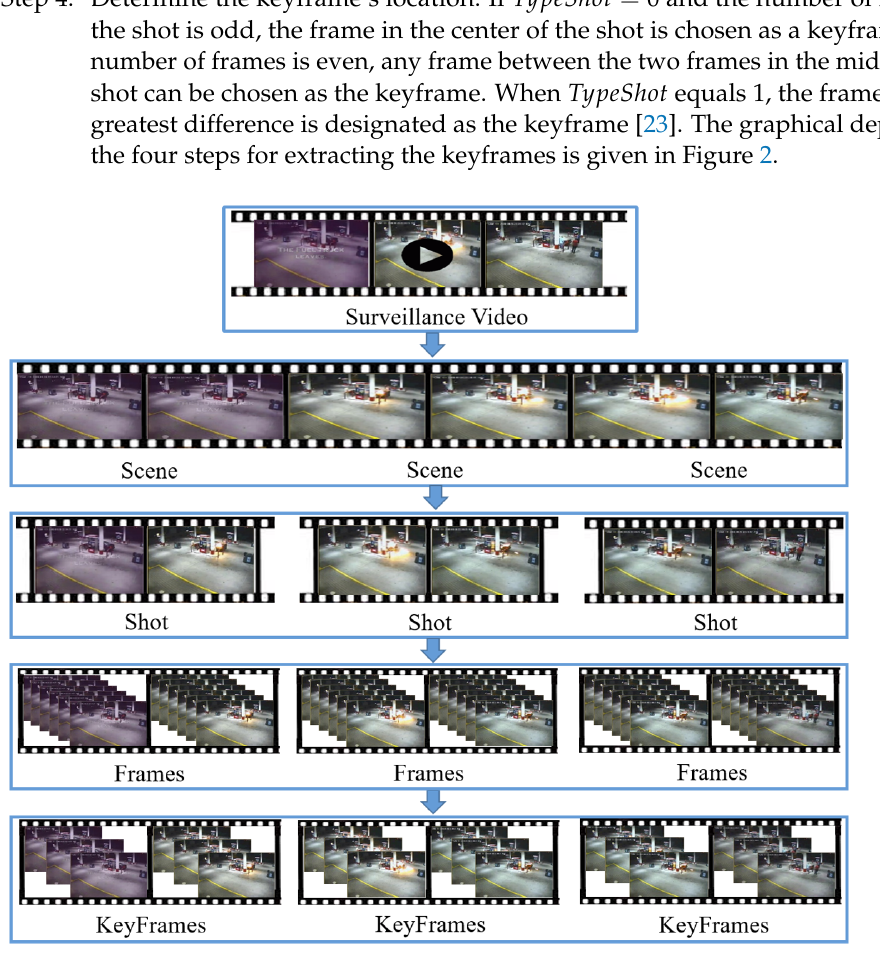
Figure 2. Steps of keyframe extraction from a given input